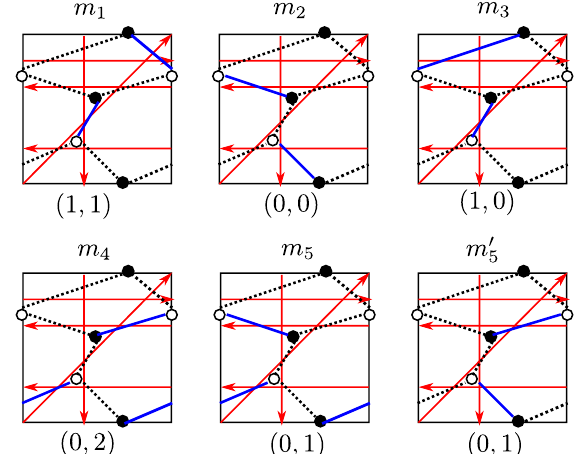
Figure 32. Perfect matchings of the suspended pinch geometry. Perfect matchings for corner divisors p are m respectively. Perfect matchings for divisor p 1 , p 2 , p 3 , p 4 1 , m 2 , m 3 , m 4